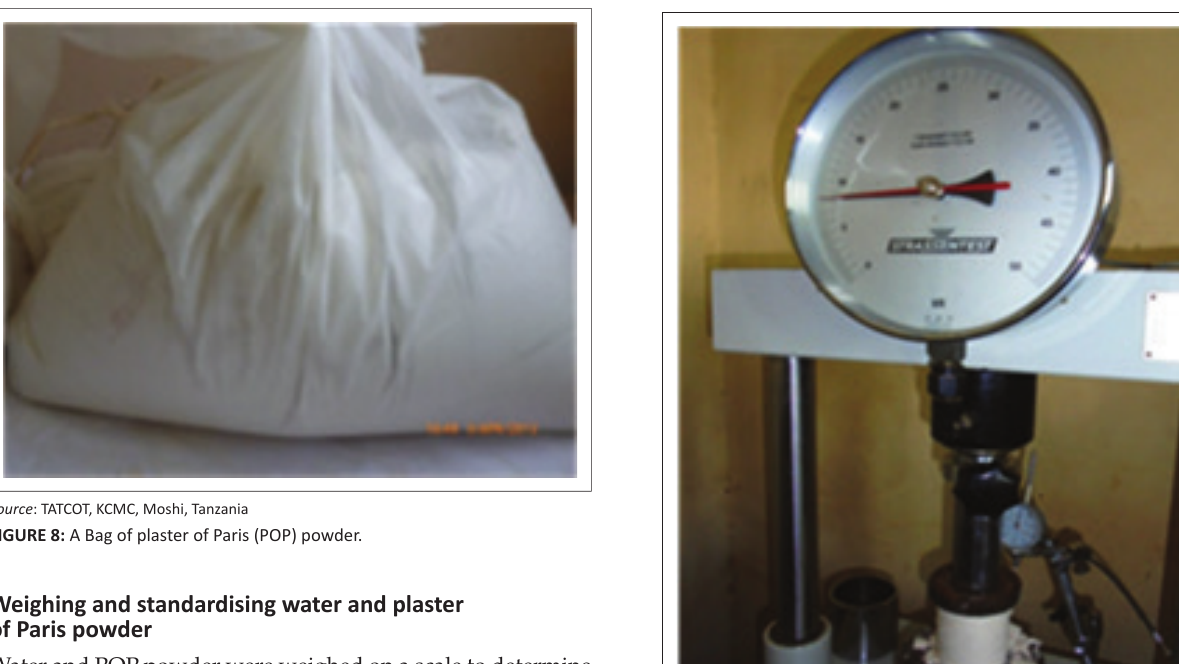
FIGURE 7: (a) Cylindrical plaster of Paris (POP) models for compressive testing; (b) A Germany Universal Testing machine (UTM), or materials test frame, is used to test the tensile strength and compressive strength of